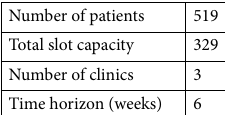
Table 1. Parameters for the analysis and data from hospital clinics.